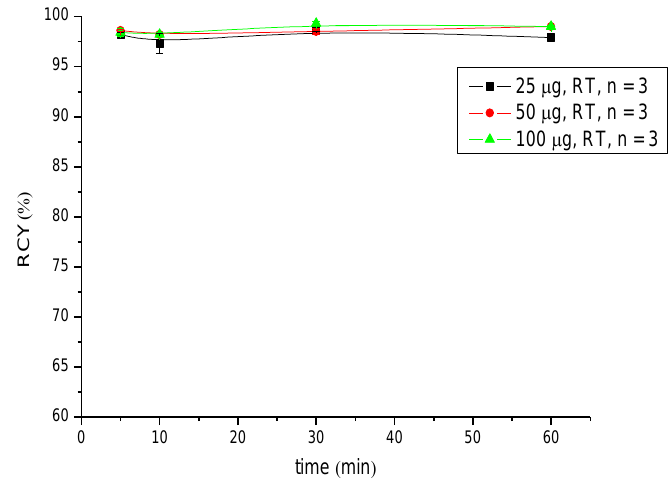
Figure 3. Dependence of the RCY of [ 90 Y]Y-CHX-A''-DTPA-DUPA-Pep on peptide amount (concentration) and reaction time at room temperature.